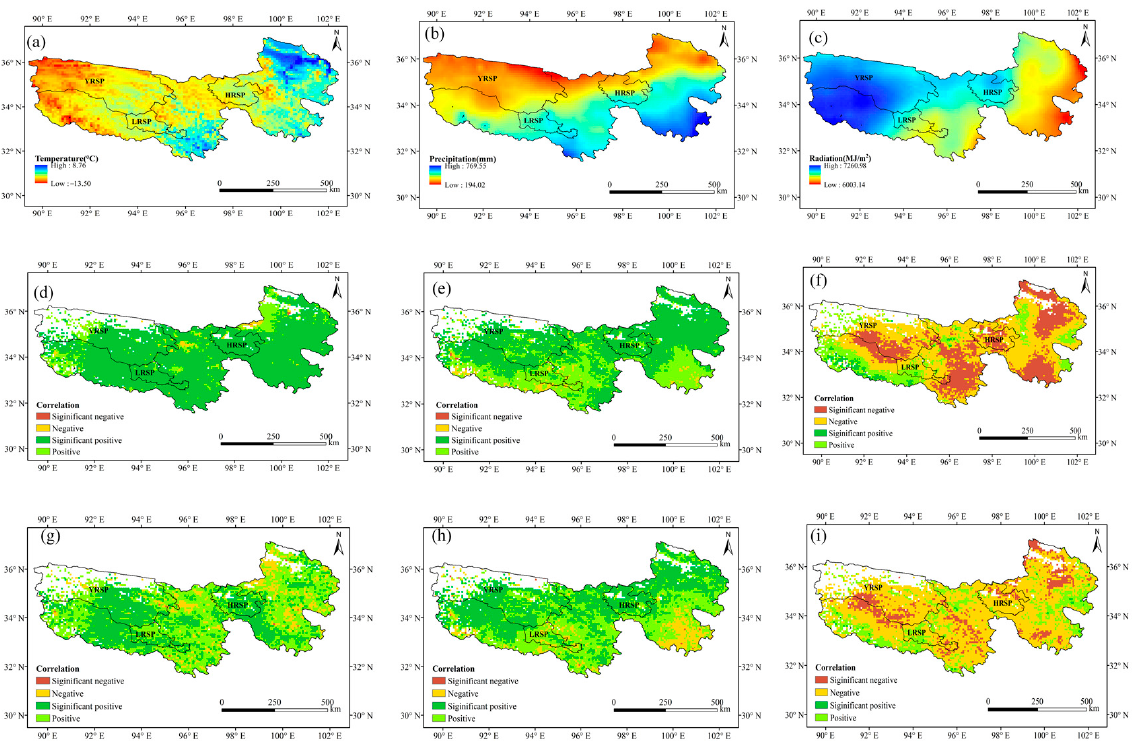
Figure 11. Spatial distribution of temperature ( a ), precipitation ( b ), and solar radiation ( c ) and the correlations between ( d ) GPP and temperature, ( e ) GPP and precipitation, ( f ) GPP and solar radiation, ( g ) NEP and temperature, ( h ) NEP and precipitation, and ( i ) NEP and solar radiation during 1985–2018.